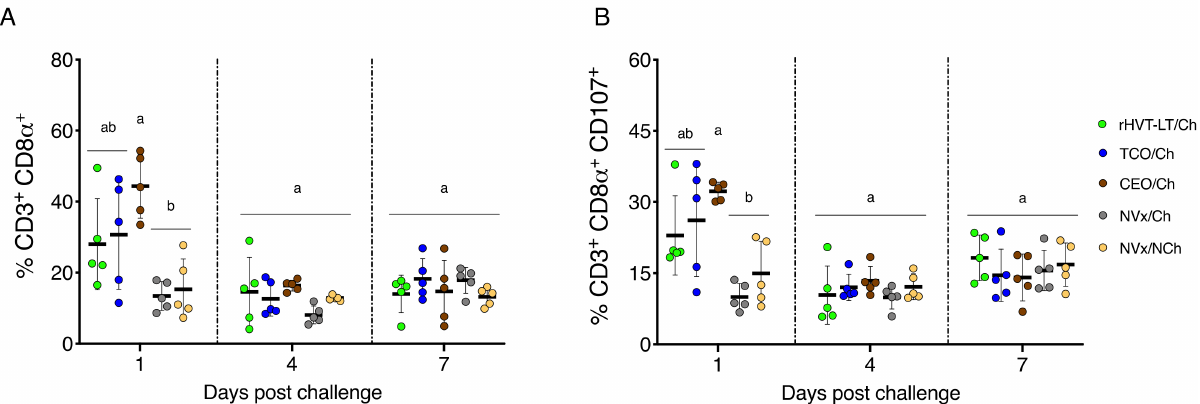
Figure 3. CTLs and activated CTLs in the larynx–trachea at 1, 4 and 7 dpch: ( A ) CTLs (CD3 + CD8 α + ); ( B ) activated CTLs (CD3 + CD8 α + CD107 + ). Small horizontal lines indicate the mean ( ± SD). Each dot represents an individual chicken (n = 5 for each group). Different letters indicate significant differences ( p <